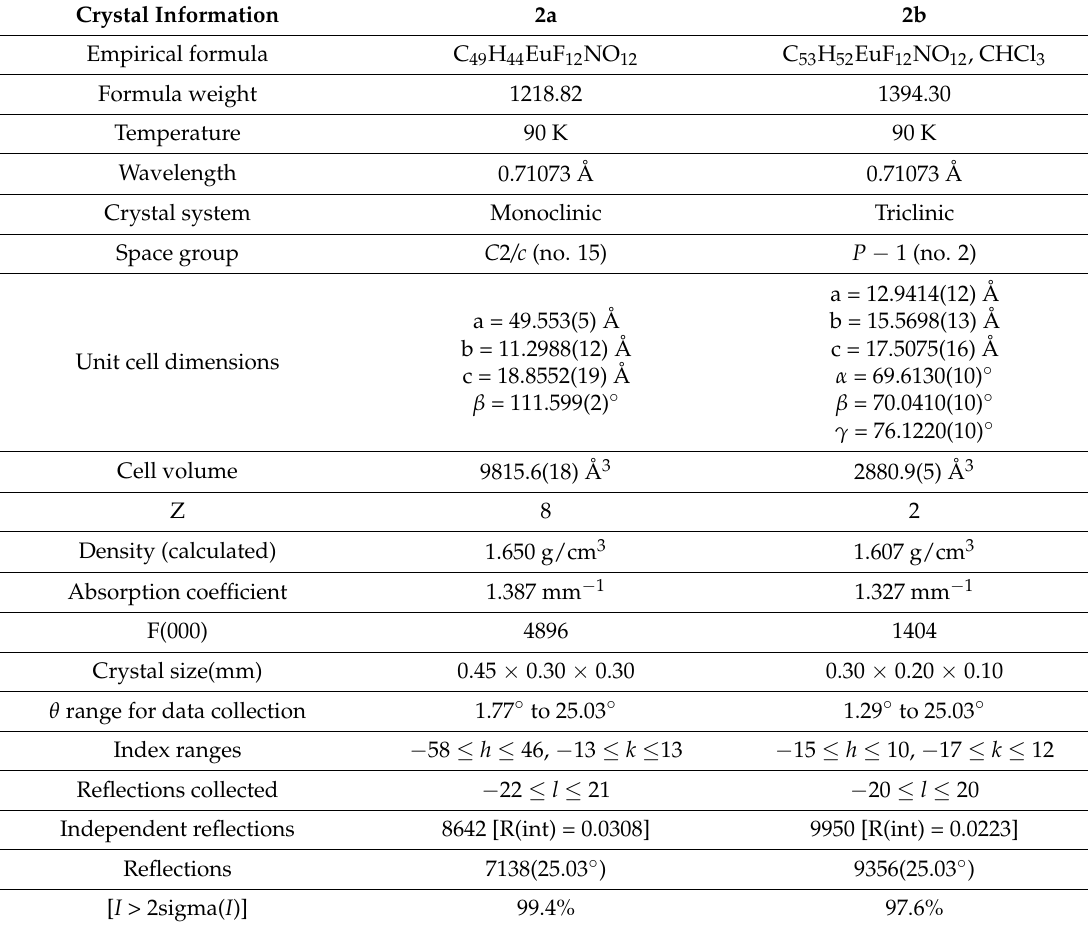
Table 3. Crystallographic data for the complexes 2a and 2b